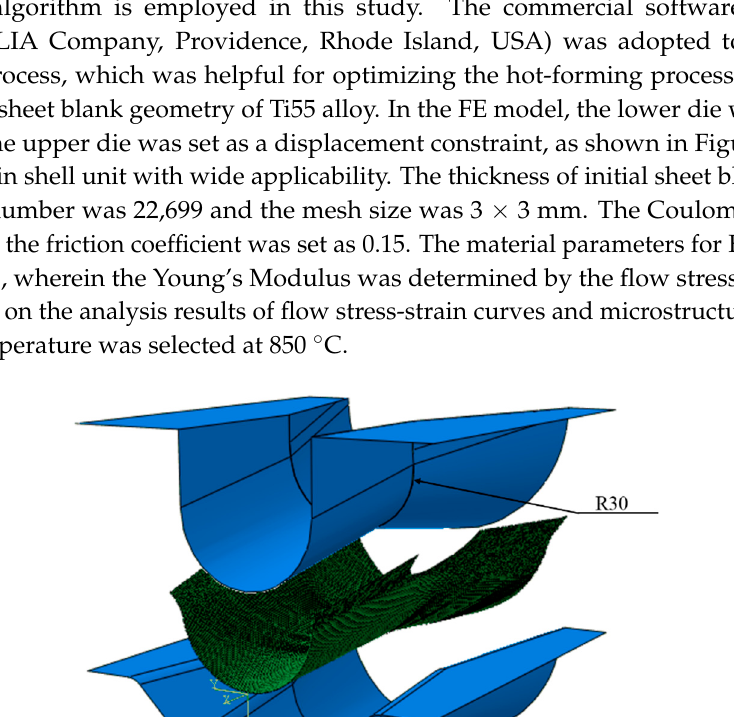
Figure 2. Schematic diagram of hot press forming of the curvilinear generatrix workpiece of Ti55 alloy. Table 1. Finite Element Method (FEM) simulation parameters of